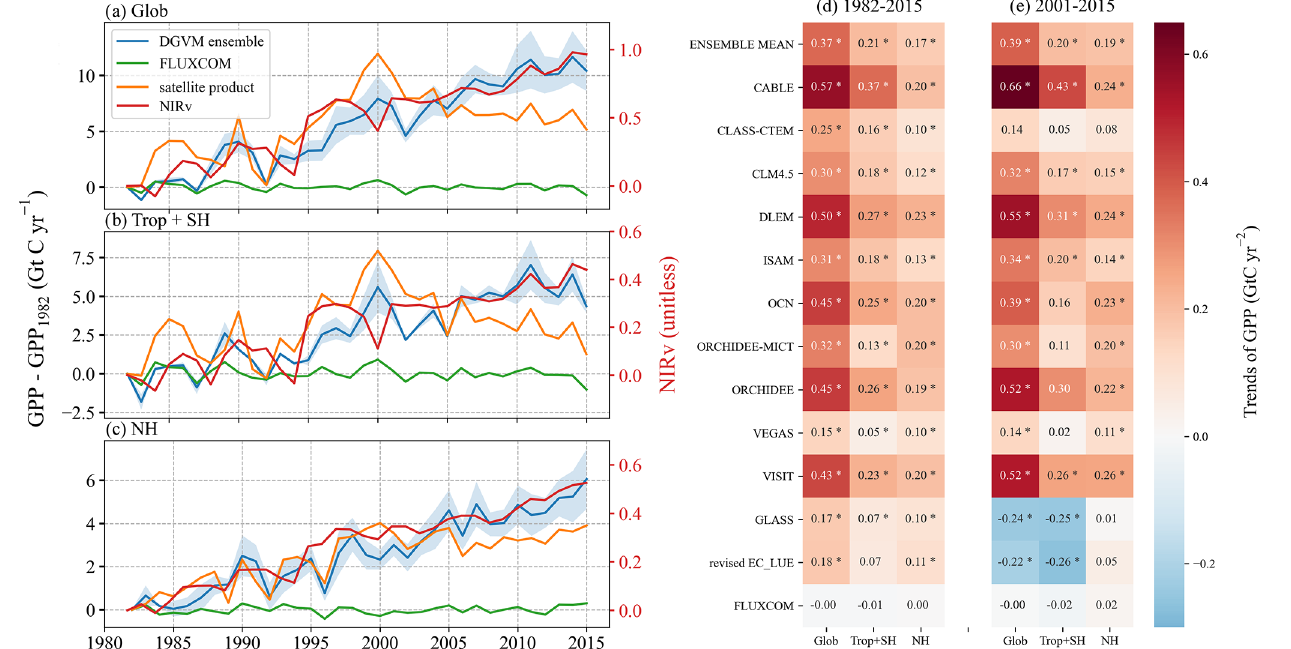
Figure 3. Linear trends of global and regional total GPP. Changes of annual total GPP relative to 1982, based on DGVM ensemble mean (blue), FLUXCOM (green), and satellite-based products (orange), compared to AVHRR-NIRv (red), for global (a) , Trop + SH (b) , and NH (c) measurements. The shaded areas denote the TRENDY inter-model 1 σ spread. ( d–e ) Global and regional GPP trends in individual models and products for the period of 1982–2015 and 2001–2015, respectively. Asterisks indicate that the trend is significant with p < 0 . 05 following the non-parametric Mann–Kendall trend